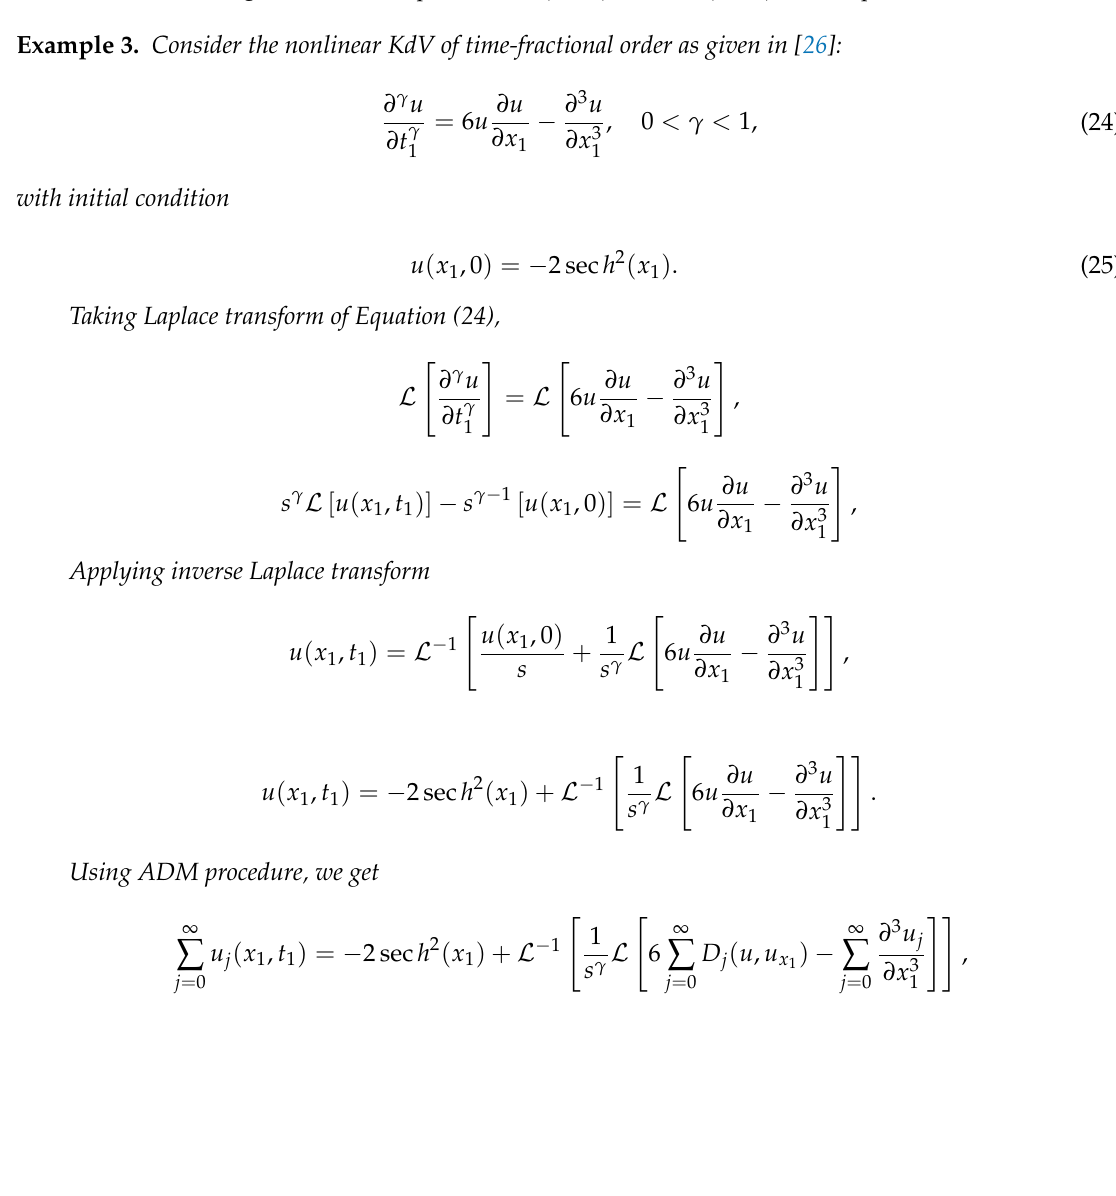
Figure 4. The error plots of ( a ) u ( x 1 , t 1 ) and ( b ) v ( x 1 , t 1 ) of Example